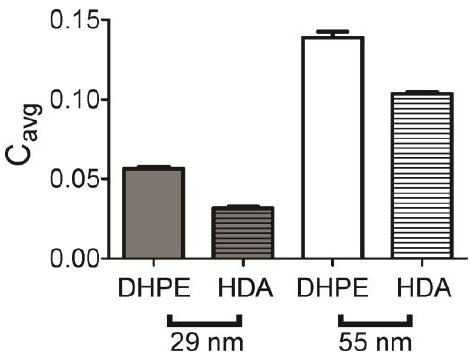
Figure 4. Pearson’s correlation coefficient was calculated for NP: lipid pairs of images that were cropped from the same sample region. DHPE (solid bars) accumulates more than HDA (striped bars).